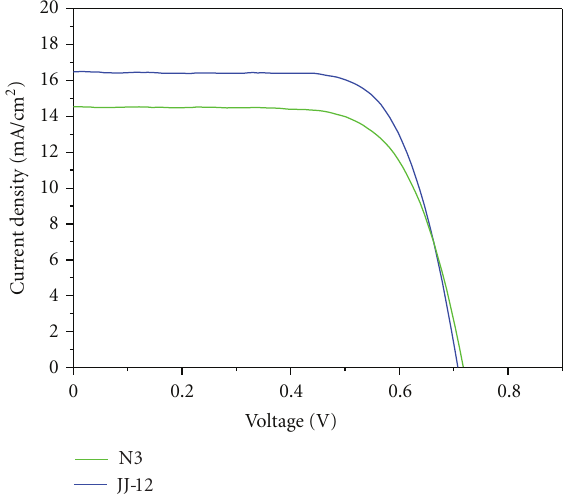
Figure 4: J - V curve of JJ-12 (blue line) and N3 (green line).